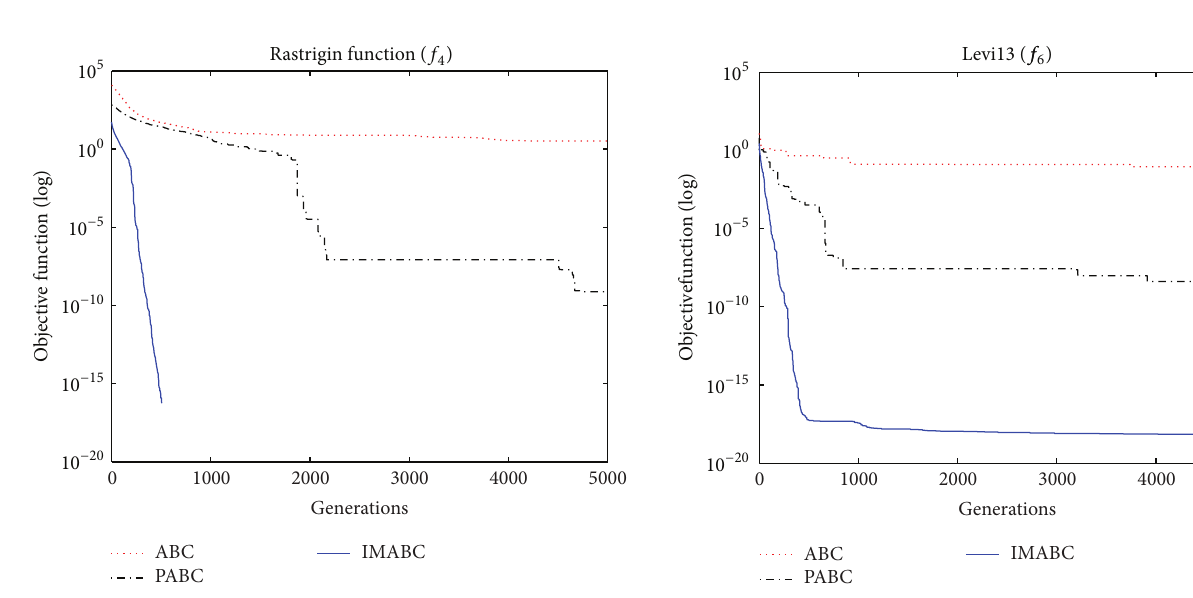
Figure 7: 𝑓 5 function convergence performance comparison.